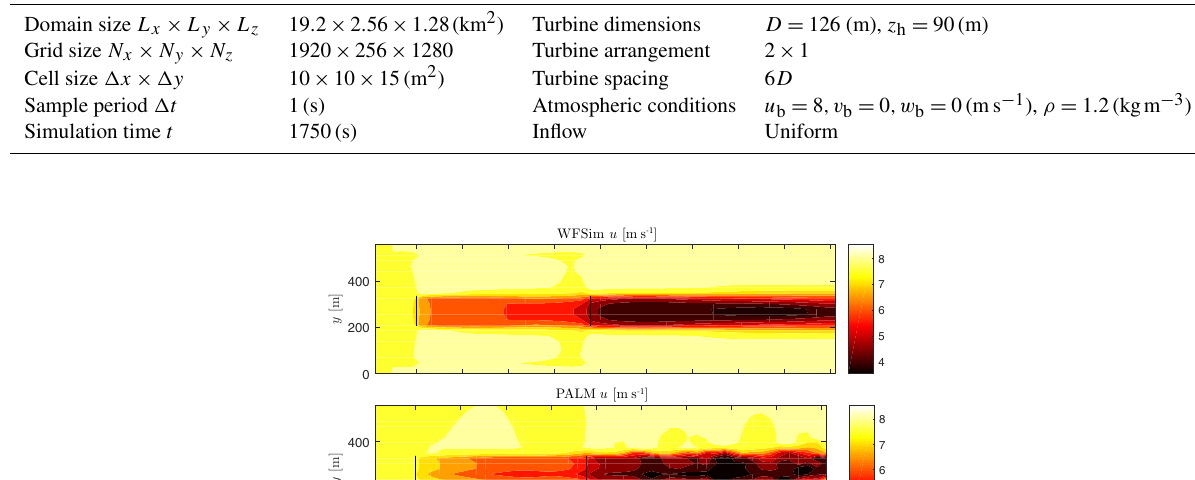
Table B1. Summary of the simulation set-up.